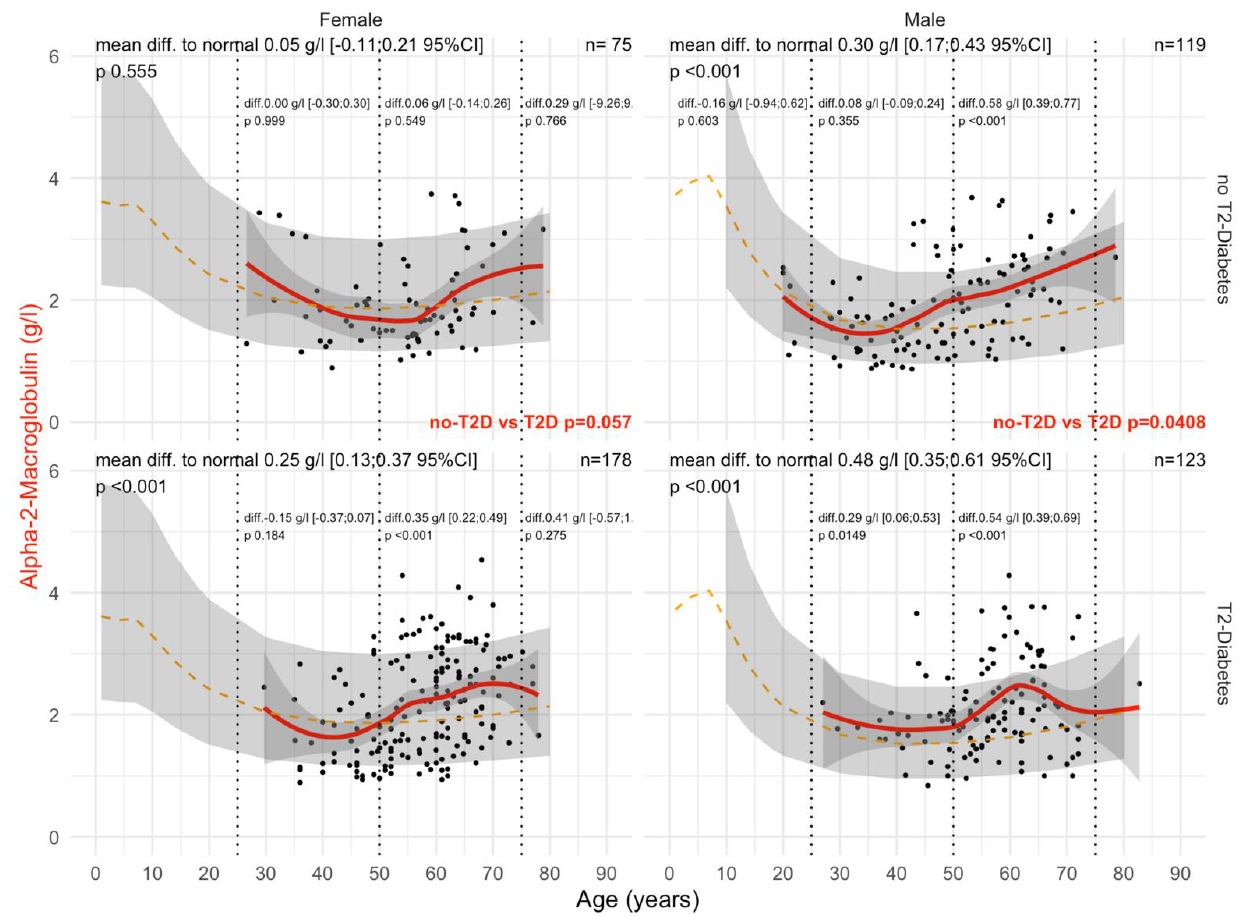
Figure 7. A2M levels in “ NAFLD-Biopsy ” patients with obesity. Impact of T2DM on A2M concentration in NAFD-biopsied patients according to obesity (n = 495). Normal serum means values according to age and sex (dashed–orange lines), with 95% confidence intervals (light-gray ribbon). Three vertical–dotted lines mark the four age groups (before 25, between 25 and 50, between 50 and 75, and above 75 years old). Each point is a patient’s protein value. The red curve is a Loess regression of the median of A2M values, along with its 95% confidence interval (darker gray). For each age group, the mean difference (%95CI) between the patient protein value and the expected normal value (for age and sex) with its significance p -value is displayed at the top of the figure. The significance between the non-T2DM and T2DM patients is displayed in red between the 2 panels.